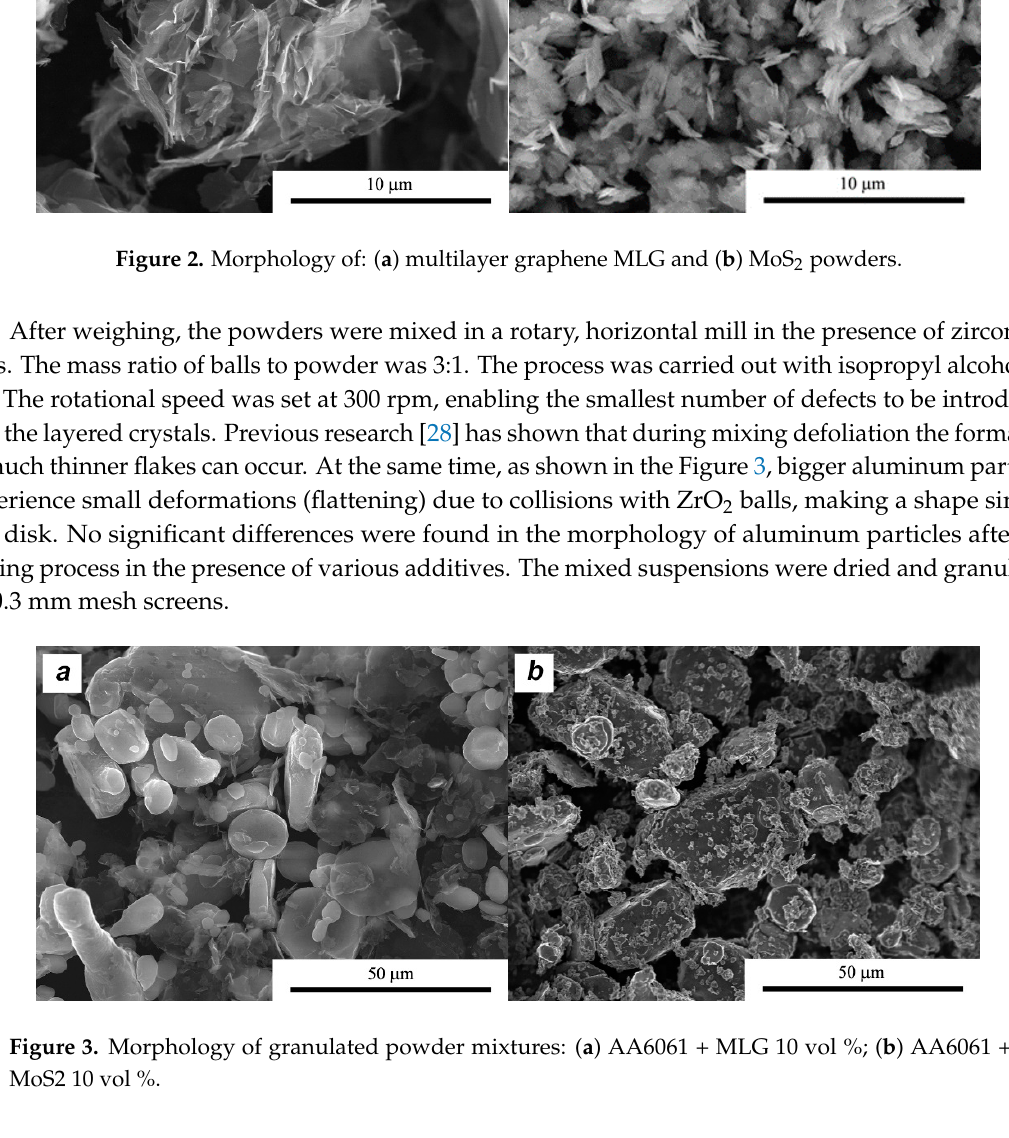
Figure 2. Morphology of: ( a ) multilayer graphene MLG and ( b ) MoS 2 powders.